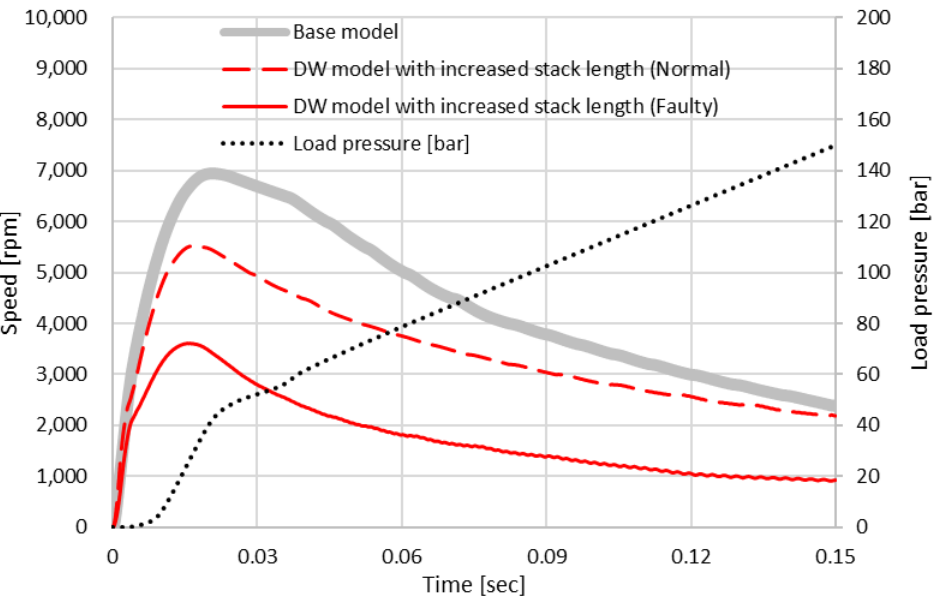
Figure 12. Comparisons of the speed response characteristics between the base model and the DWM with an increased stack length.